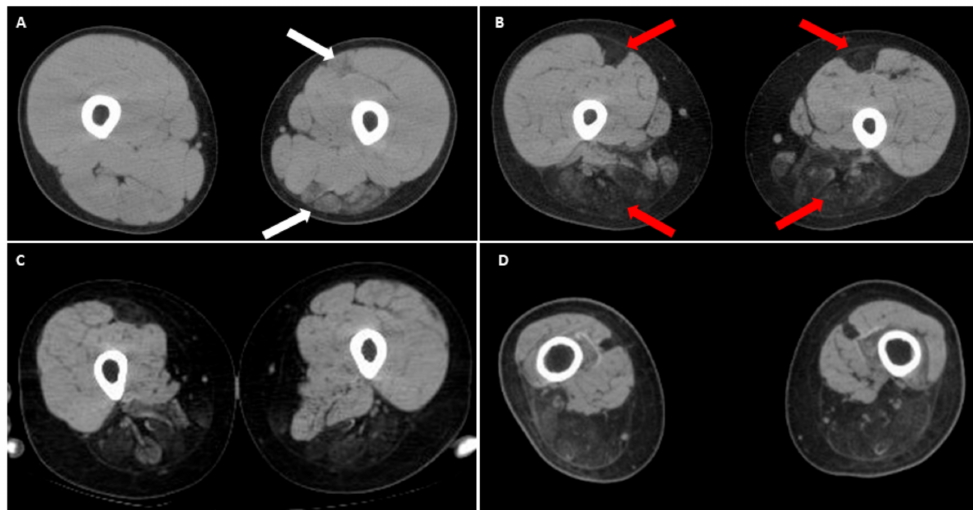
Figure 3. Muscle computed tomography (CT) of upper thighs in infantile FSHD patients. ( A ) A male with 13 kb E co RI showing early degeneration of left hamstring muscles and rectus femoris (white arrows) at 12 years old, compared to a relatively normal appearance of right thigh muscles; ( B ) Follow-up at 15 years old showing a rapid progression of muscle degeneration depicting a “wrench-head” appearance caused by extensive muscle wasting at the bilateral hamstring muscles with selectively a ff ected rectus femoris of quadriceps (red arrows). Another two CT findings of ( C ) right leg of a 16-year-old female (11 kb Eco RI), and ( D ) both legs of a 28-year-old male (10 kb Eco RI), showing a similar muscle pattern, respectively. Informed consents were obtained from above reported